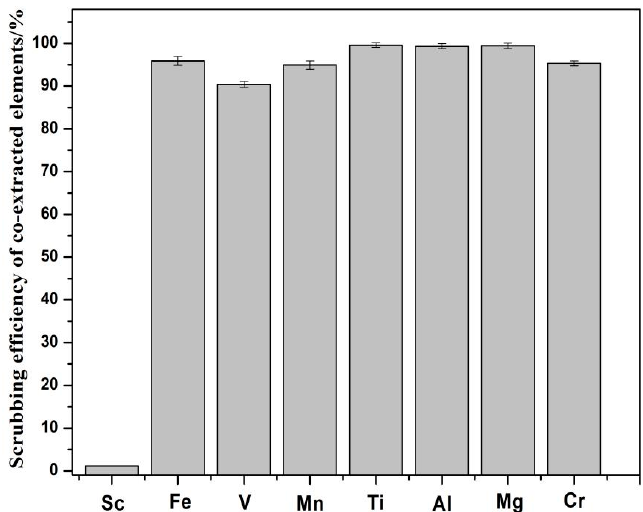
Figure 7. Scrubbing of co-extracted elements (O/A = 2:1 and 4 mol/L HCl for 5 min at 298 K).